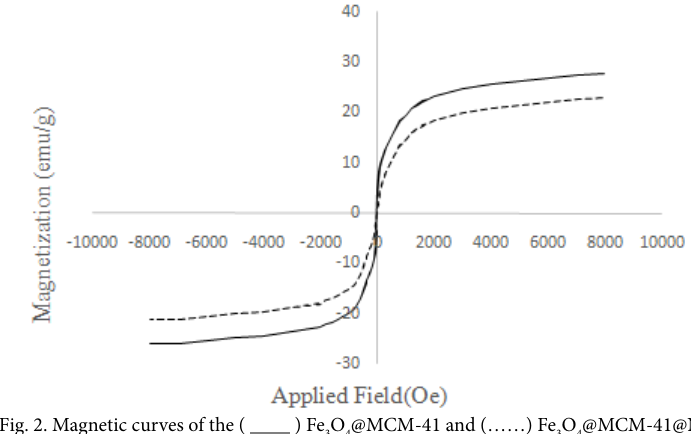
O @MCM-41@NH 3 4 2